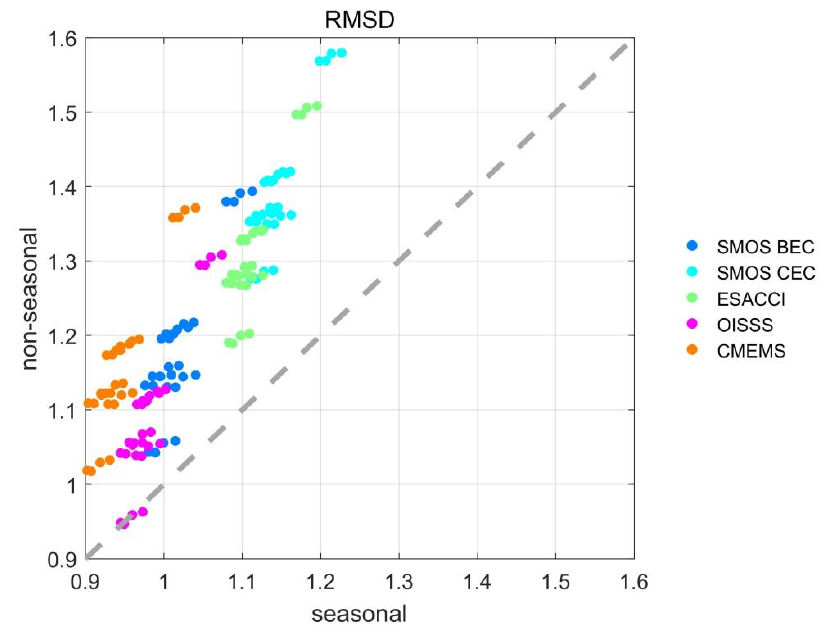
Figure 11. RMSD between FWF and SSS tendency on a seasonal time scale vs. nonseasonal time scale. The dots denote correlation coefficients calculated between SSS tendency based on 5 products (different colors) and 28 sets of FWF (same color). Units for RMSD are g/kg/year.